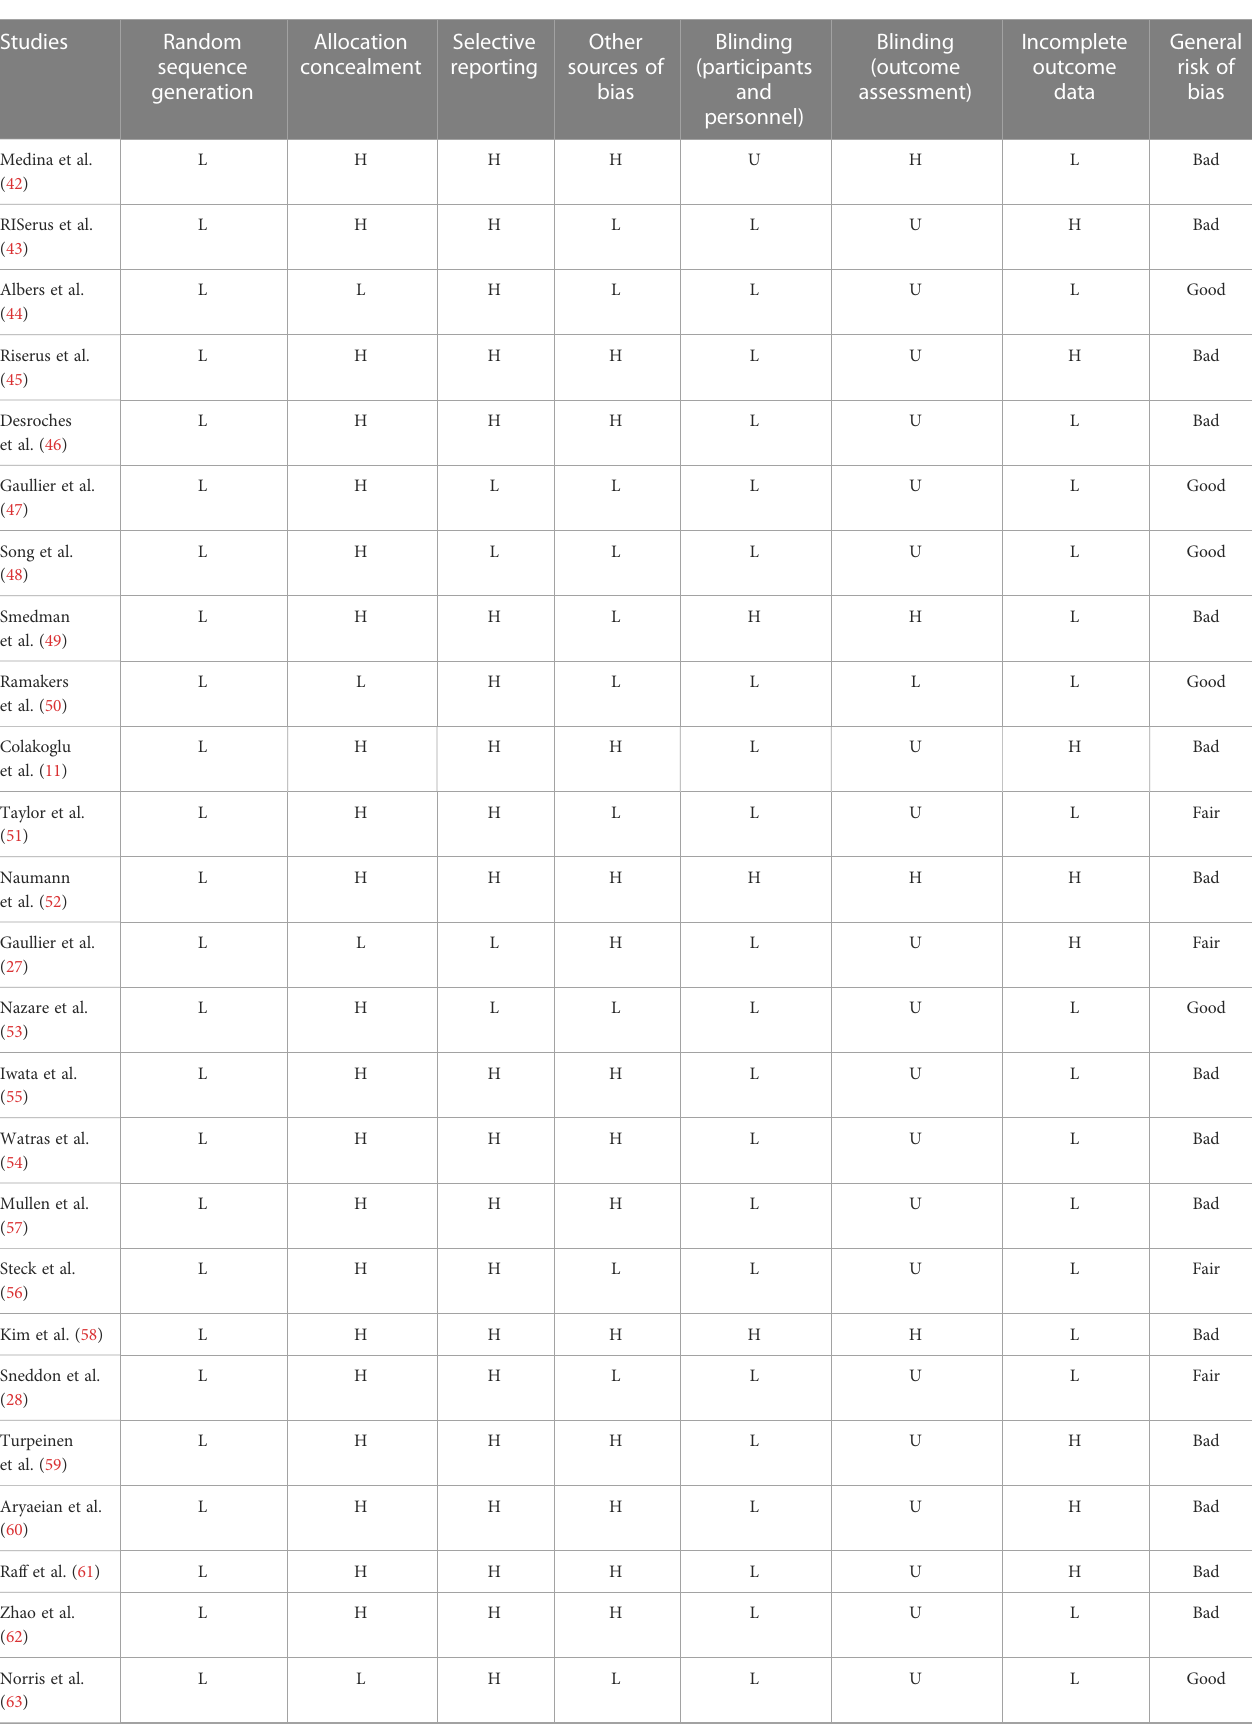
TABLE 2 Risk of bias